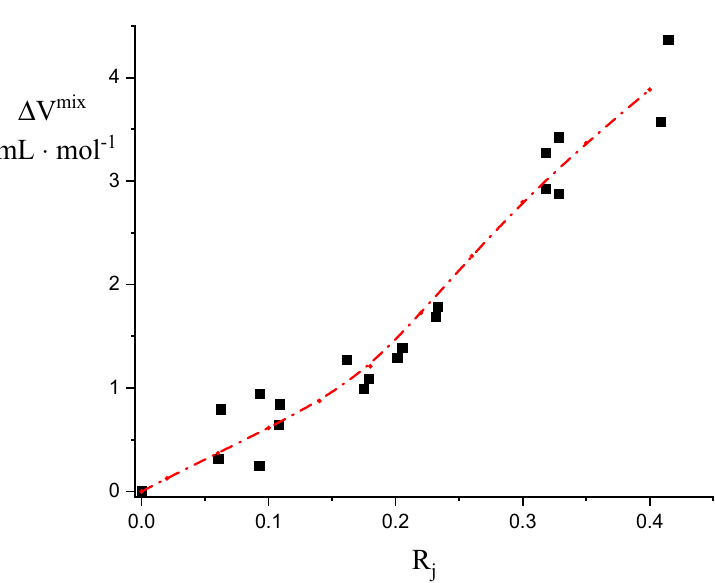
Figure 9. Volume change of mixing, ∆ V mix , calcium ions with L. hyp. alginate in aqueous 0.05 M NaClO 4 at 25.0 ◦ C, as a function of R j (full black squares). Data taken from reference [24]. The red dash-dotted curve is the best-fit curve through the data according to Equation (18) (see text).